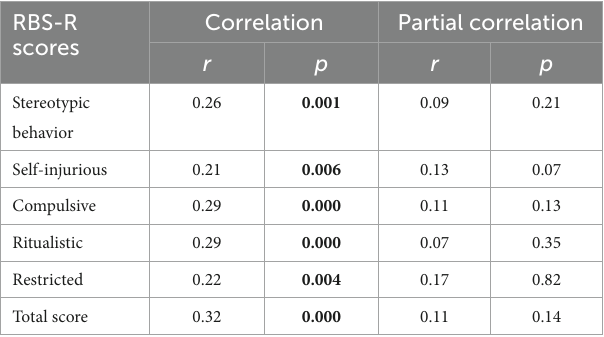
TABLE 7 Correlations between RBS-R subscale and CSHQ-total score, and partial correlations controlling for anxiety (DOS-CBCL anxiety